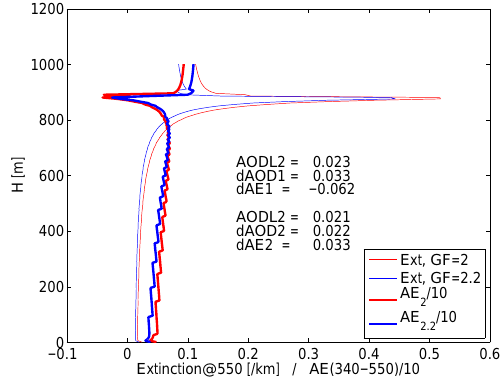
Figure 5. Profile of extinction at 500nm and Ångström exponent from 340 to 500nm wavelength pair. The latter is divided by 10, in order to better match the x scale. The numbers within the figure are given for the simulations of two different cases of growth factors (2 and 2.2). The first three numbers are for the case of growth factor of 2 as follows: AOD of clear-sky profile, “AODL2”; AOD differ- ence between cloudy and clear-sky profiles, “dAOD1”; AE differ- ence between cloudy and clear-sky profile, “dAE1”. The next three numbers correspond similarly to the case of increased growth factor of